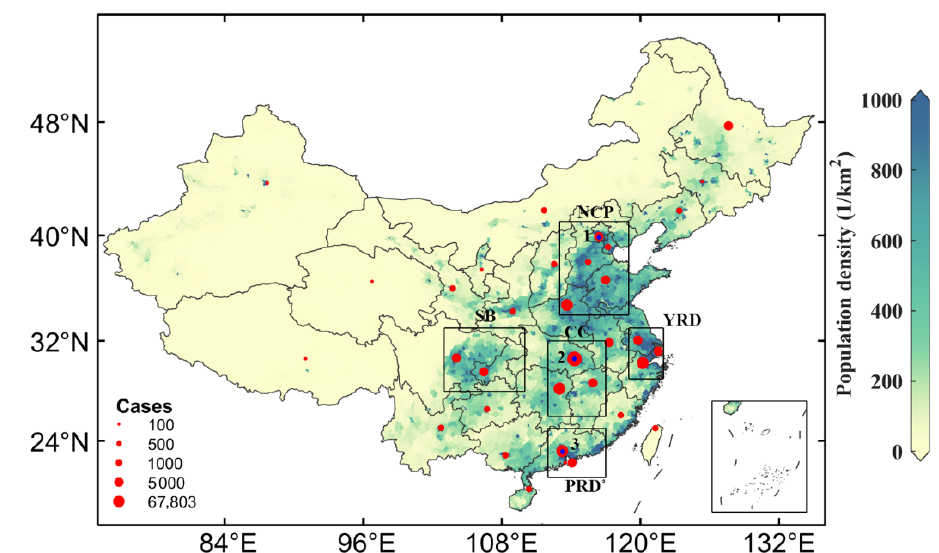
Figure 1. Colorbar represents China’s population density (people per km 2 ) map, with 1.4 billion people. The circles represent the cumulative number of cases reported by 8 April 2020, 76 days after the Wuhan lockdown on 23 January. Location of regions in study areas (black square), including NCP, CC, YRD, PRD, and SB. The blue dots represent Beijing (1), Wuhan (2), and Guangzhou (3), respectively.